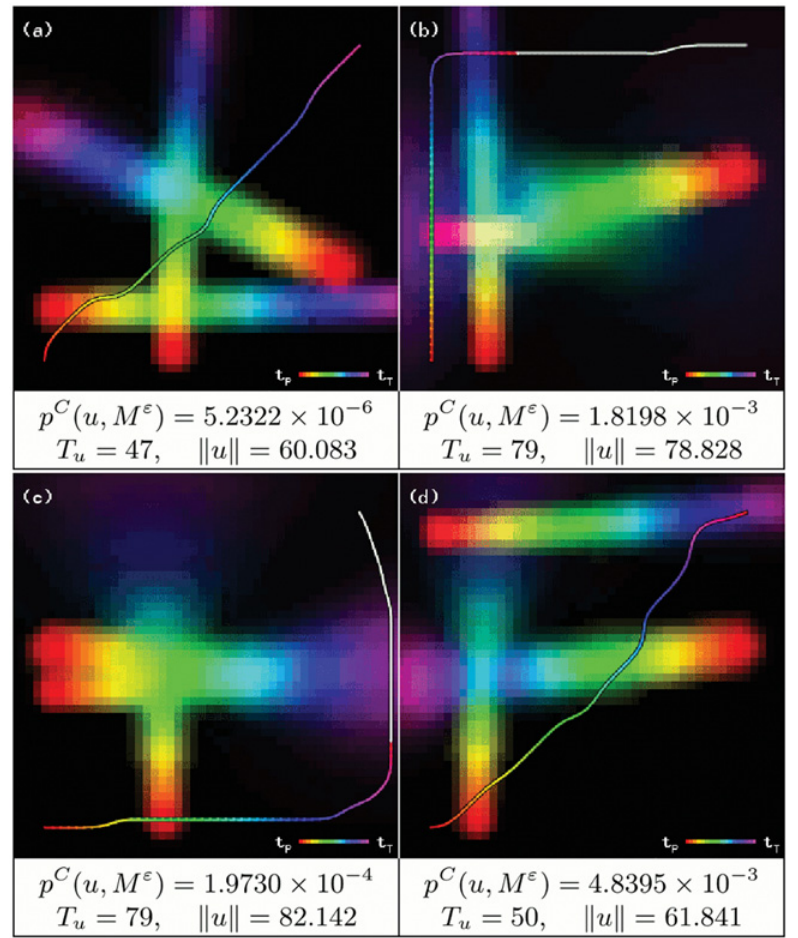
Fig 5. Examples of trajectories with minimum collision probability.